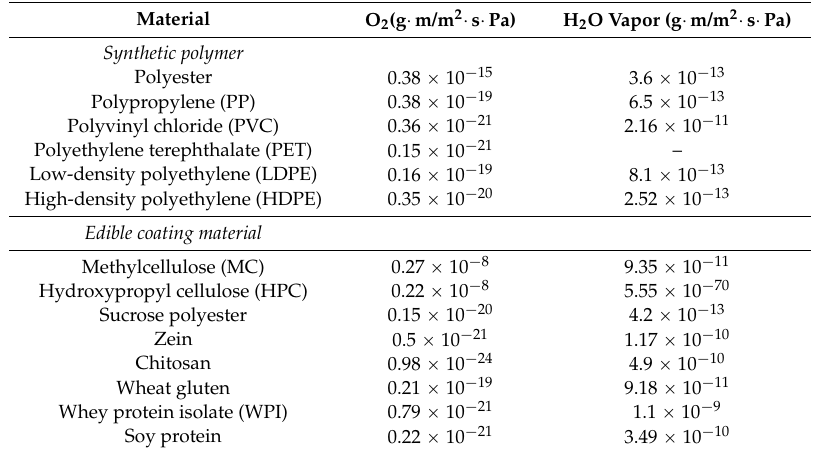
Table 6. Comparison of permeability (at 25 ˘ 2 ˝ C, 50% to 70% relative humidity (RH)) of some synthetic polymers with edible films/coatings